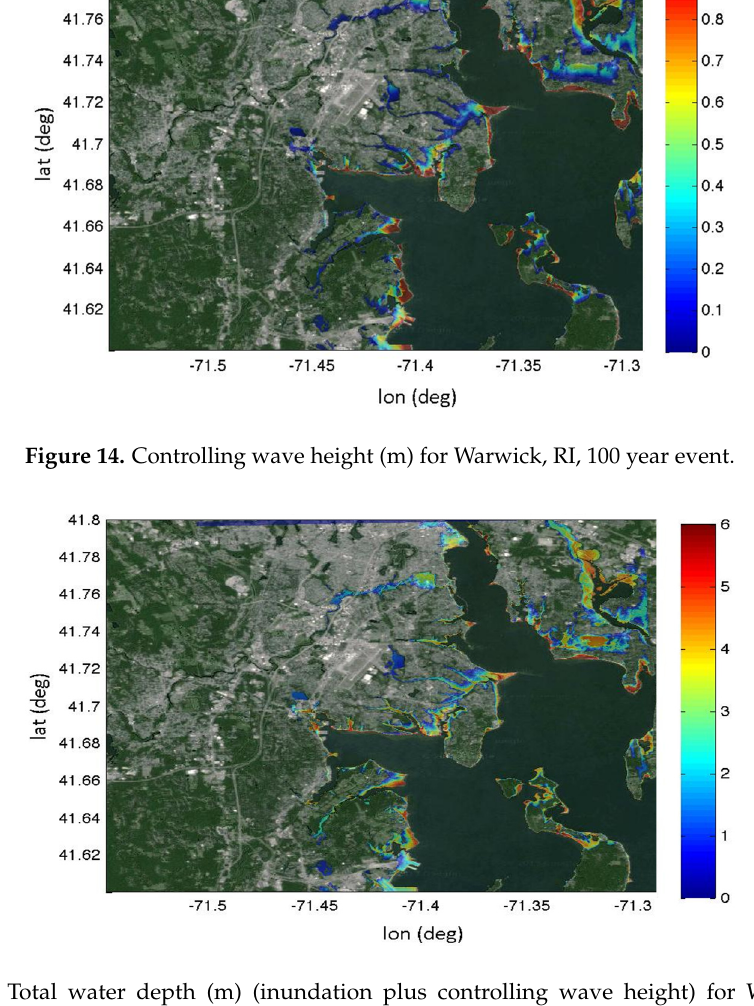
Figure 15. Total water depth (m) (inundation plus controlling wave height) for Warwick, RI, 100 year event.